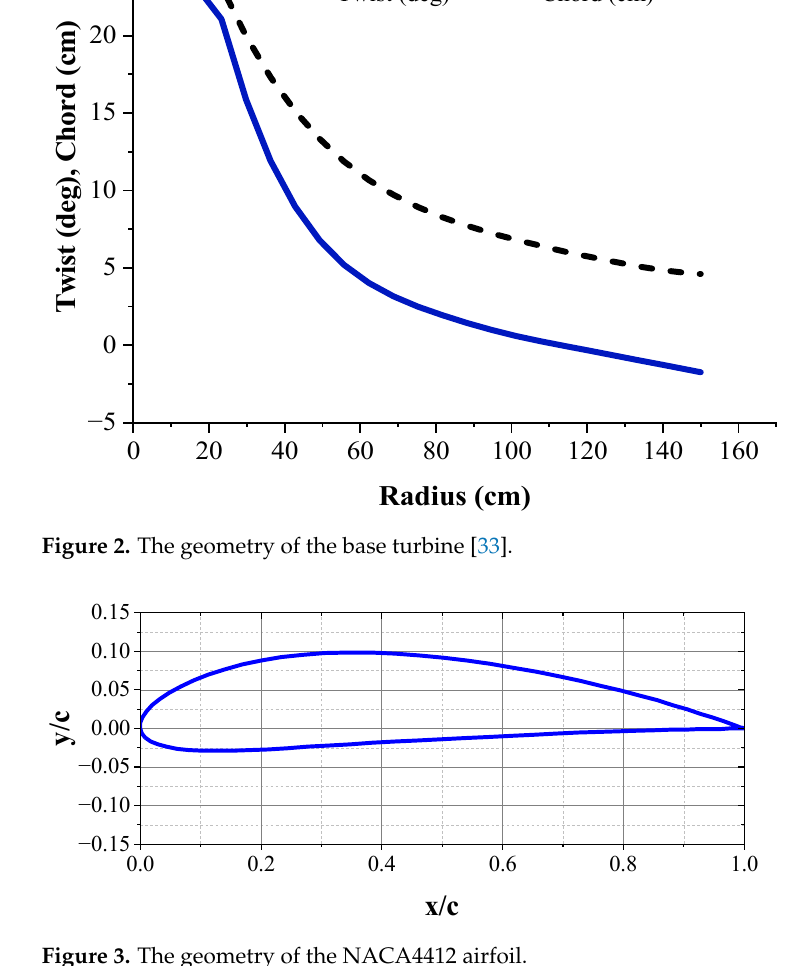
Figure 3. The geometry of the NACA4412 airfoil.